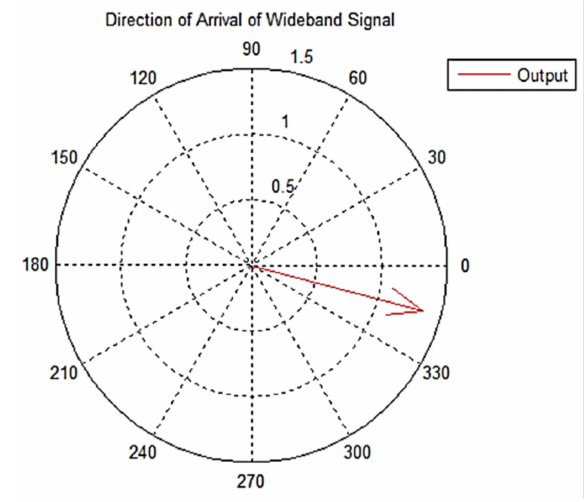
Figure 9. Estimated direction of arrival of sound.